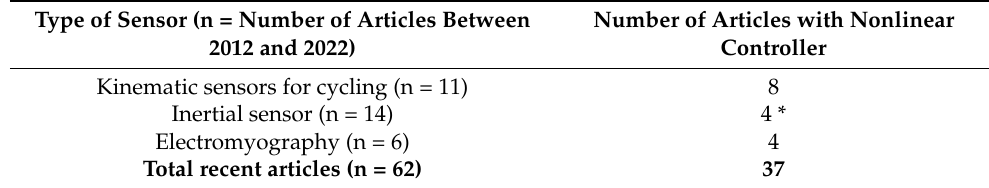
Table 3. Control strategies for simple flexion-extension movements of a limb. LLLC